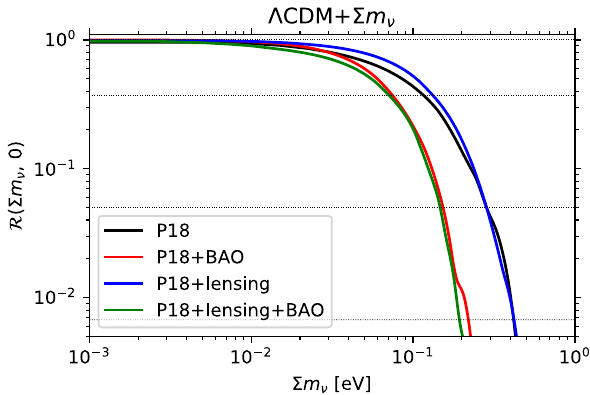
Fig. 2 The R (Σ m ν , 0 ) function in Eq. (9) obtained from the Planck 2018 chains [7] for different data combinations, considering the Λ CDM+ Σ m ν model. The horizontal lines show the levels ln R = 0, − 1, − 3, − 5,